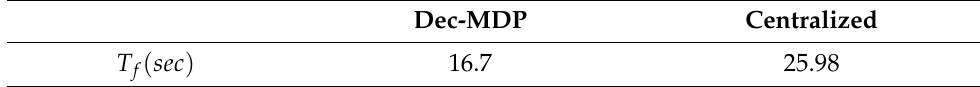
Table 1. Average time taken by the swarm to arrive at the formation